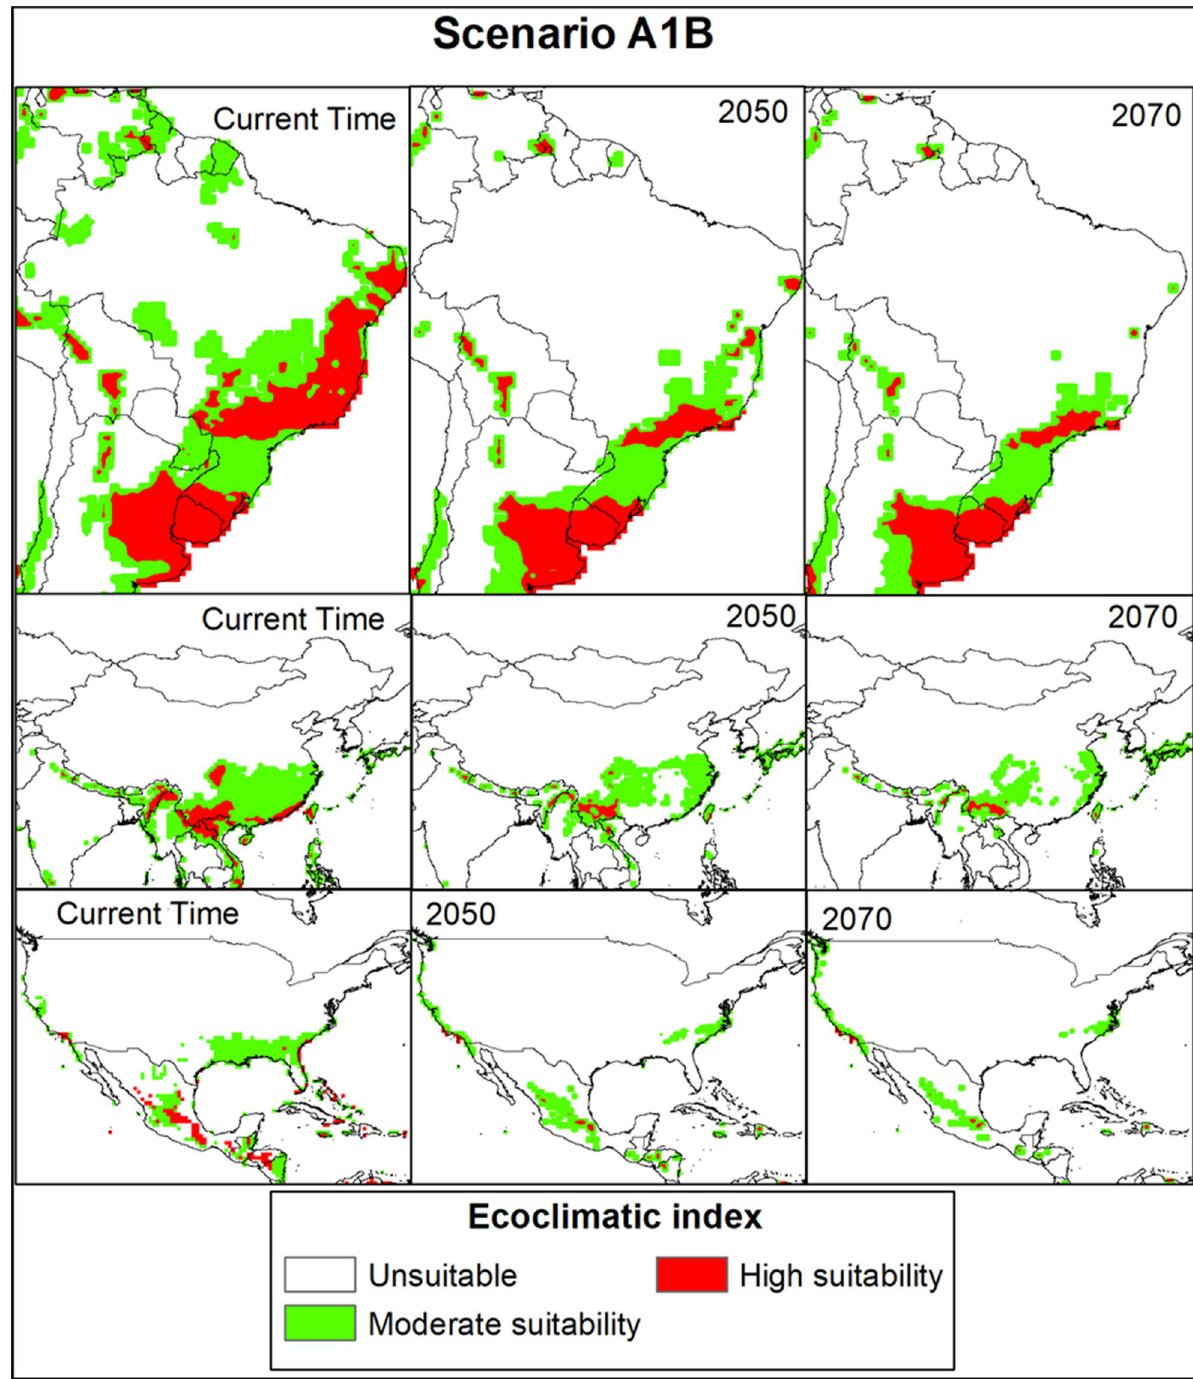
Figure 6. The Ecoclimatic Index (EI) for Trioza erytreae in A1B scenario for the current time, 2050 and 2070, respectively, in Brazil, China, and USA (the largest citrus-producing countries). ESRI ArcMap 10.2.2 (https:// suppo rt. esri. com/ en/ Produ cts/ Deskt op/ arcgis- deskt op/ arcmap/ 10-2- 2# downl oads) and CLIMEX 4.0.0 (https:// www. hearne. softw are/ Softw are/ CLIMEX- DYMEX/ Editi